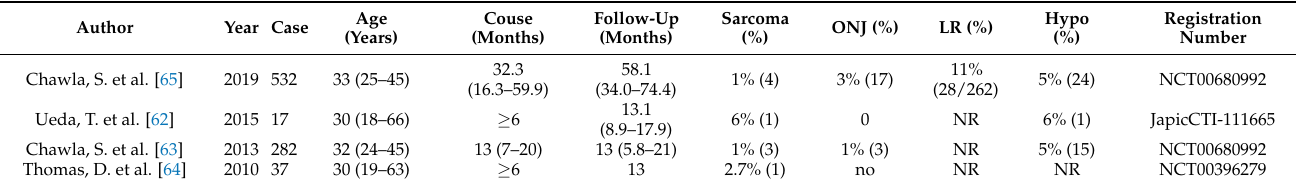
Table 1. Multicenter phase 2 clinical studies for giant cell tumor of